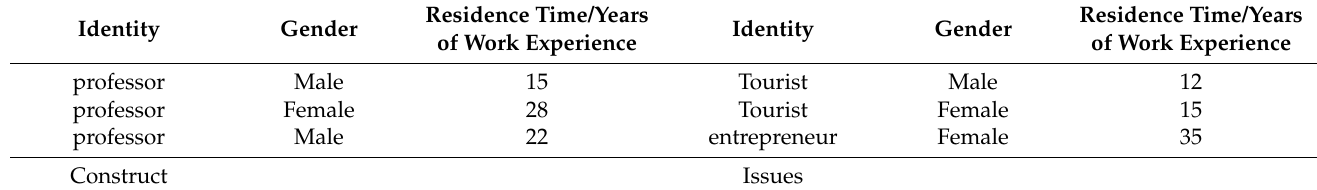
Table 1. Respondent’s background information and an overview of the interview